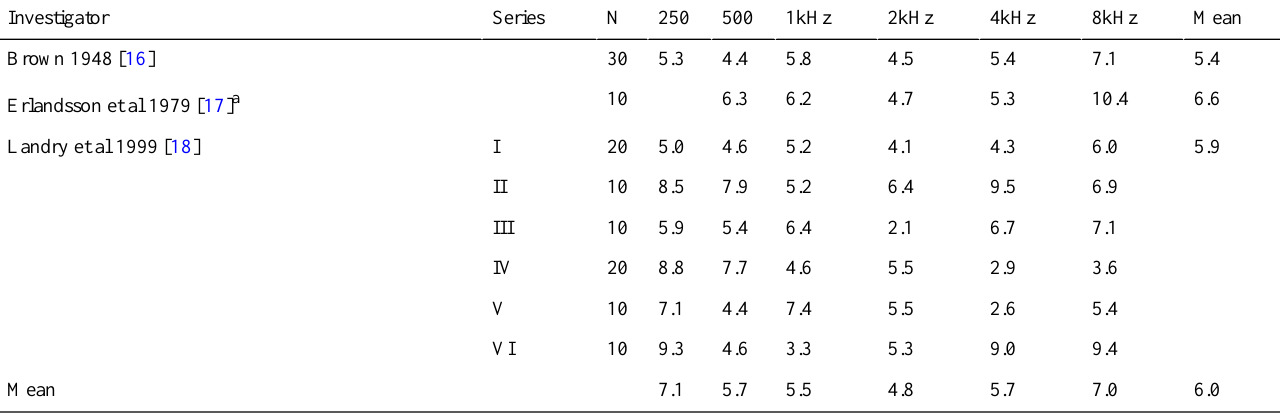
Table 3. Standard deviations of the hearing threshold obtained in test-retest examination (literature data) (separate measurements were carried out for supra-aural headphones (series I, II, III) and in-ear headphones (IV, V, VI) and for the group of young (series I and IV), older (II, V) and the oldest (III, VI) subjects; N=number of subjects)